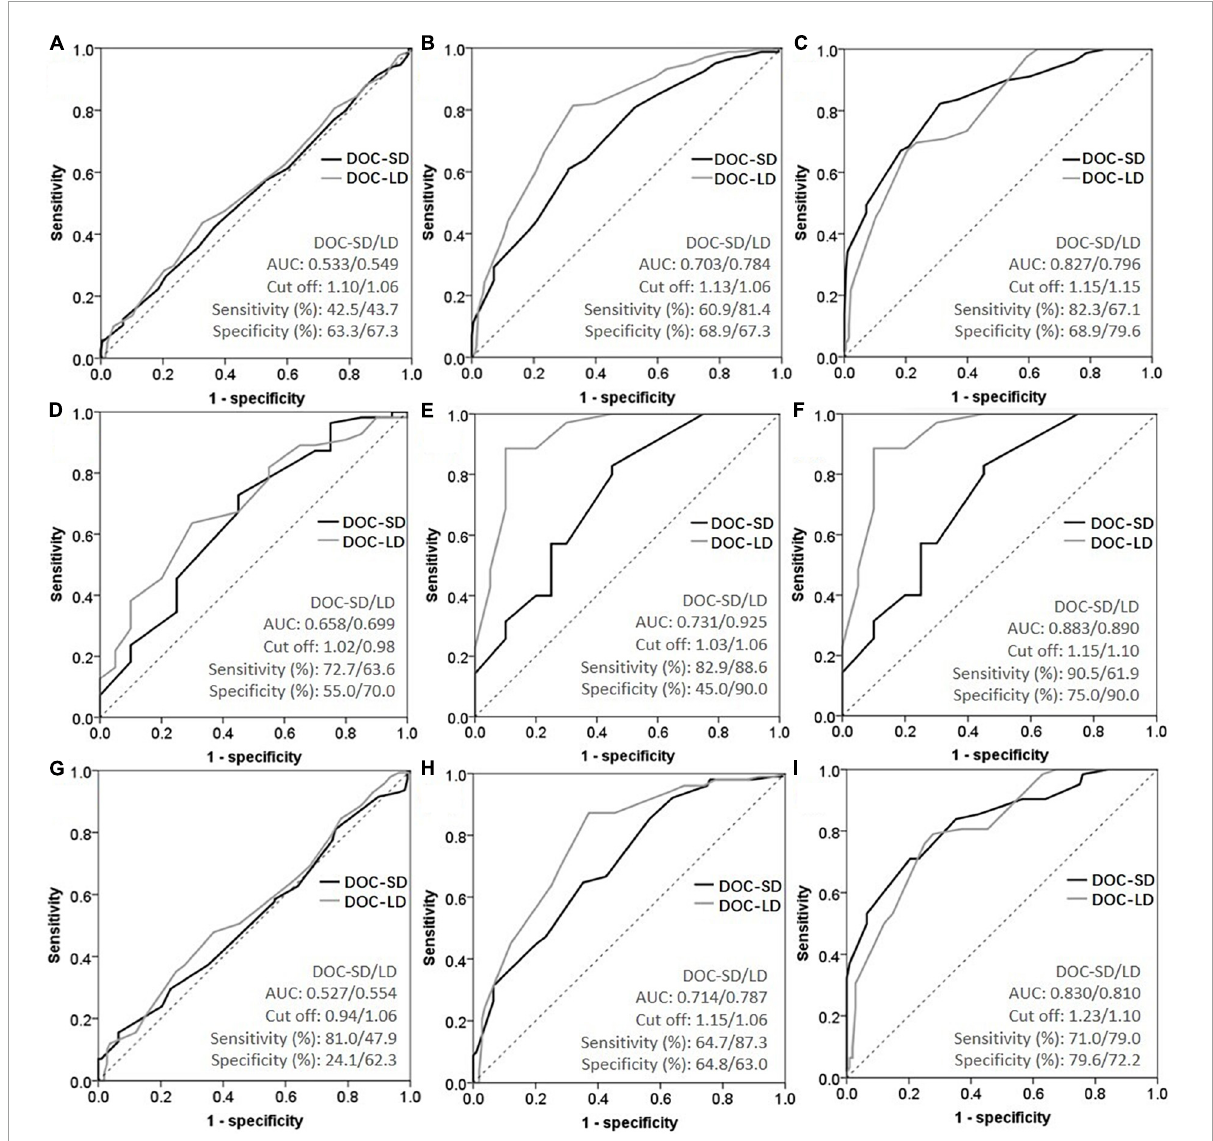
FIGURE3 Receiver operating characteristic curve (ROC) curves of metamemory scores in all participants [ (A) subjective cognitive decline (SCD) vs. cognitively unimpaired (CU); (B) amnestic mild cognitive impairment (aMCI) vs. CU; (C) Alzheimer’s disease (AD) vs. CU], A β + subgroup [ (D) SCD vs. CU; (E) aMCI vs. CU; (F) AD vs. CU], and age ≥ 65 subgroup [ (G) SCD vs. CU; (H) aMCI vs. CU; (I) AD vs. CU].